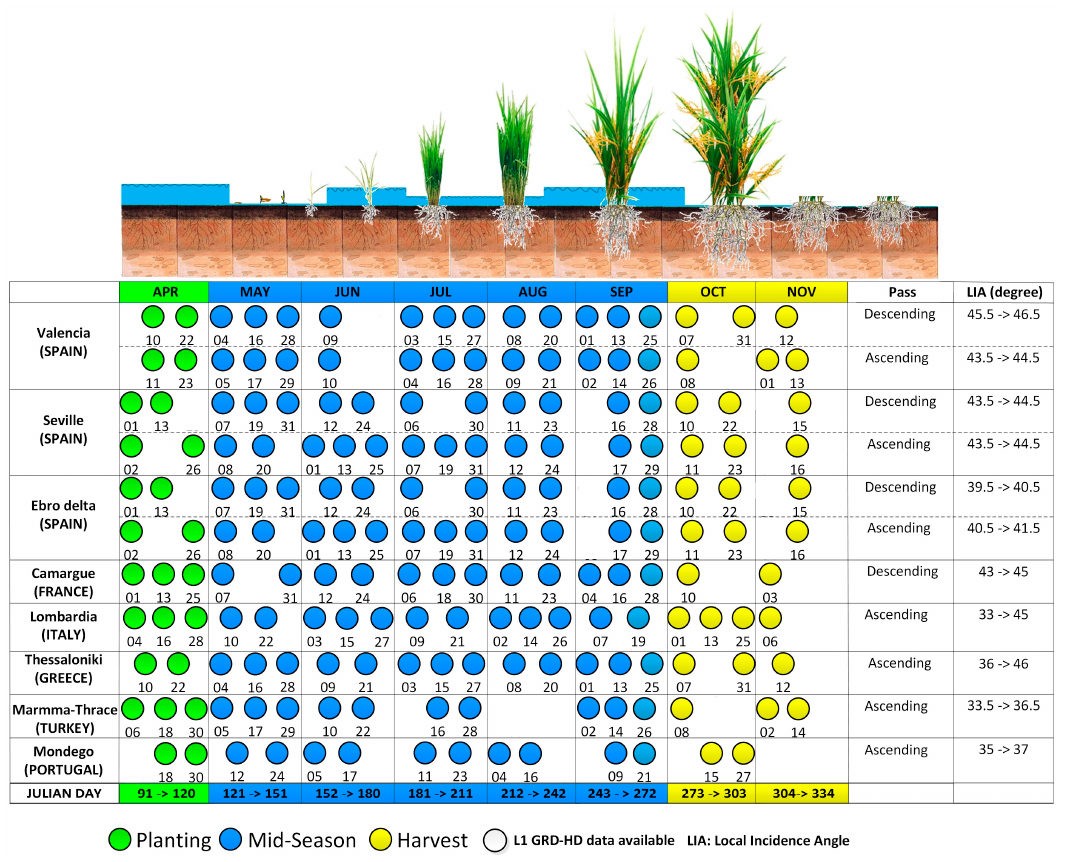
Figure 4. Growing season of paddy rice crop and the available S-1A SAR scenes over eight selected test sites.